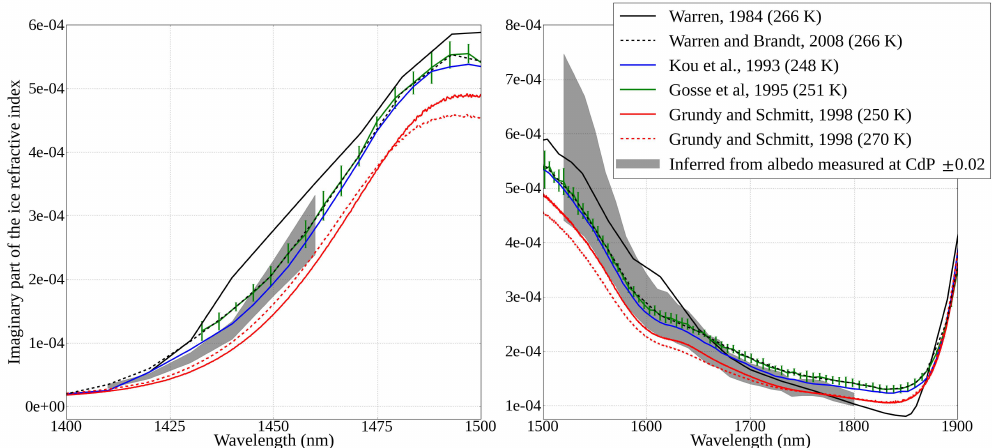
Fig. 13. Imaginary part of the ice refractive index from the literature and inferred from our albedo measurements. Several compilations are presented: Warren (1984) at 266K (black solid line), Warren and Brandt (2008) at 266K (black dashed line), Kou et al. (1993) at 248K (blue solid line), Gosse et al. (1995) at 251K (green solid line with error bars, as reported in their study), Grundy and Schmitt (1998) at 250K (red solid line) and 270K (red dashed line). Thick grey lines correspond to the values of the refractive index needed to obtain a simulated albedo within ± 0.02 of our measurements at Col de Porte (see Fig. 12).